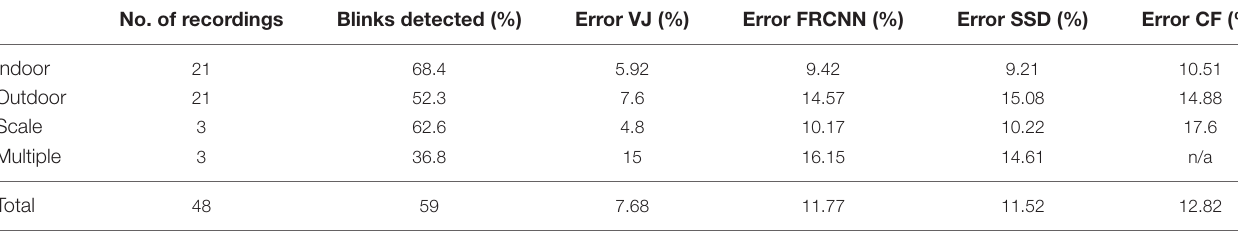
TABLE 2 | Summary of results for detection and tracking for four sets of